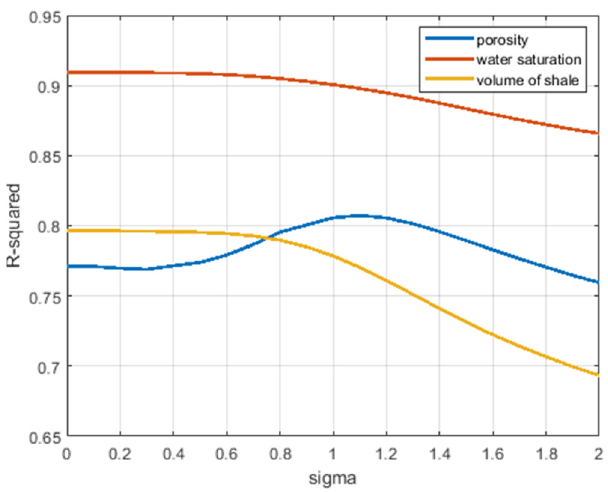
Figure 10. Cross-plot between accuracy R 2 (R-squared) and smoothing factor (sigma) of porosity, water saturation and volume of shale prediction for σ (sigma) value scanned between 0 and 2.